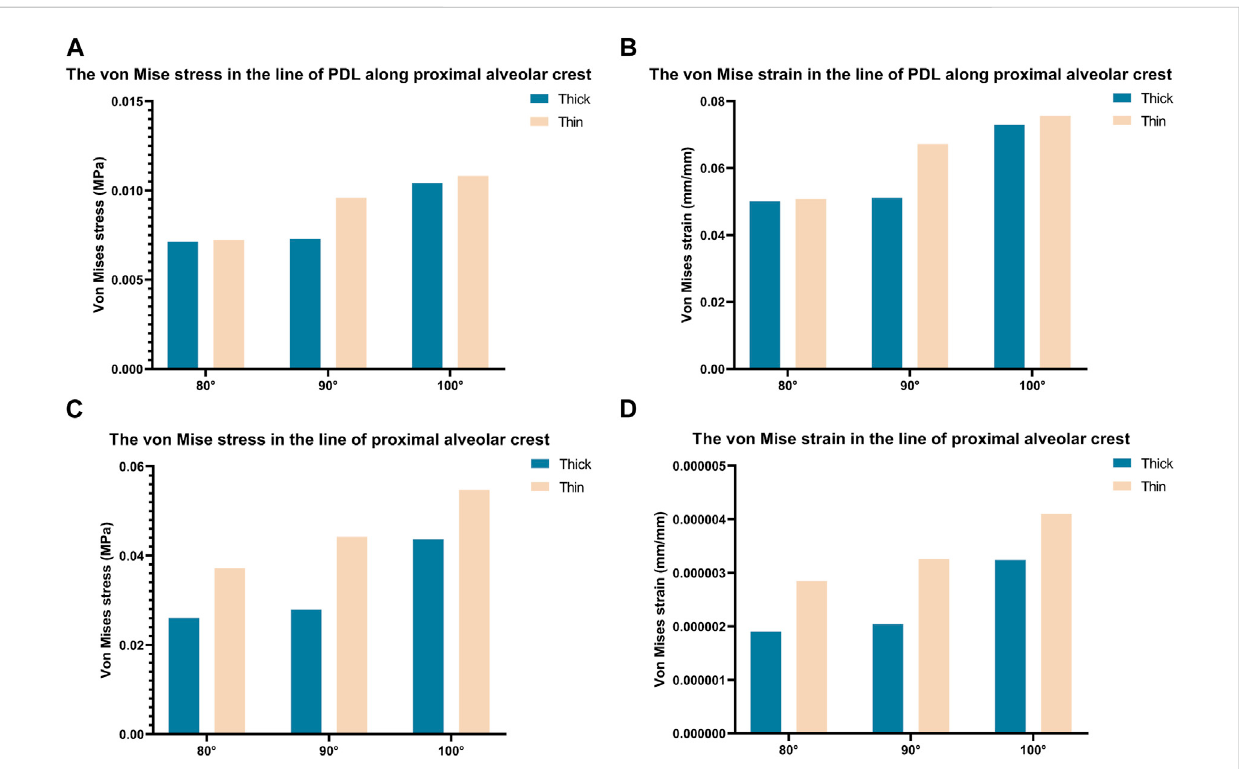
FIGURE 5 Bar chart of maximum von Mise stress and strain along a line generated along the proximal alveolar crest in various models (Thick-80 ° ; Thick-90 ° ; Thick-100 ° ; Thin-80 ° ; Thin-90 ° ; Thin-100 ° ).